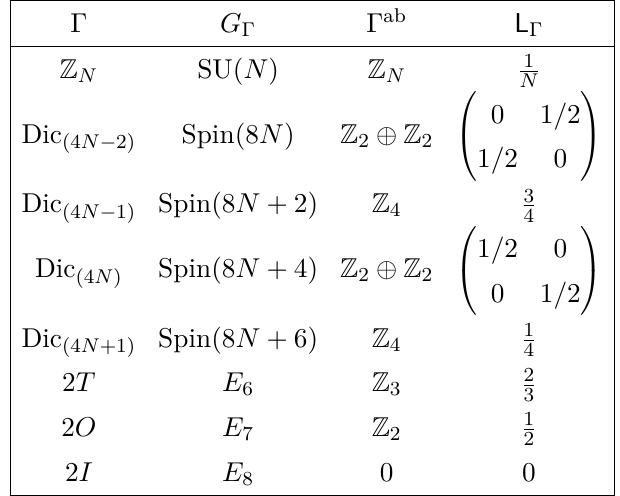
Table 1 . Linking pairings for G Γ